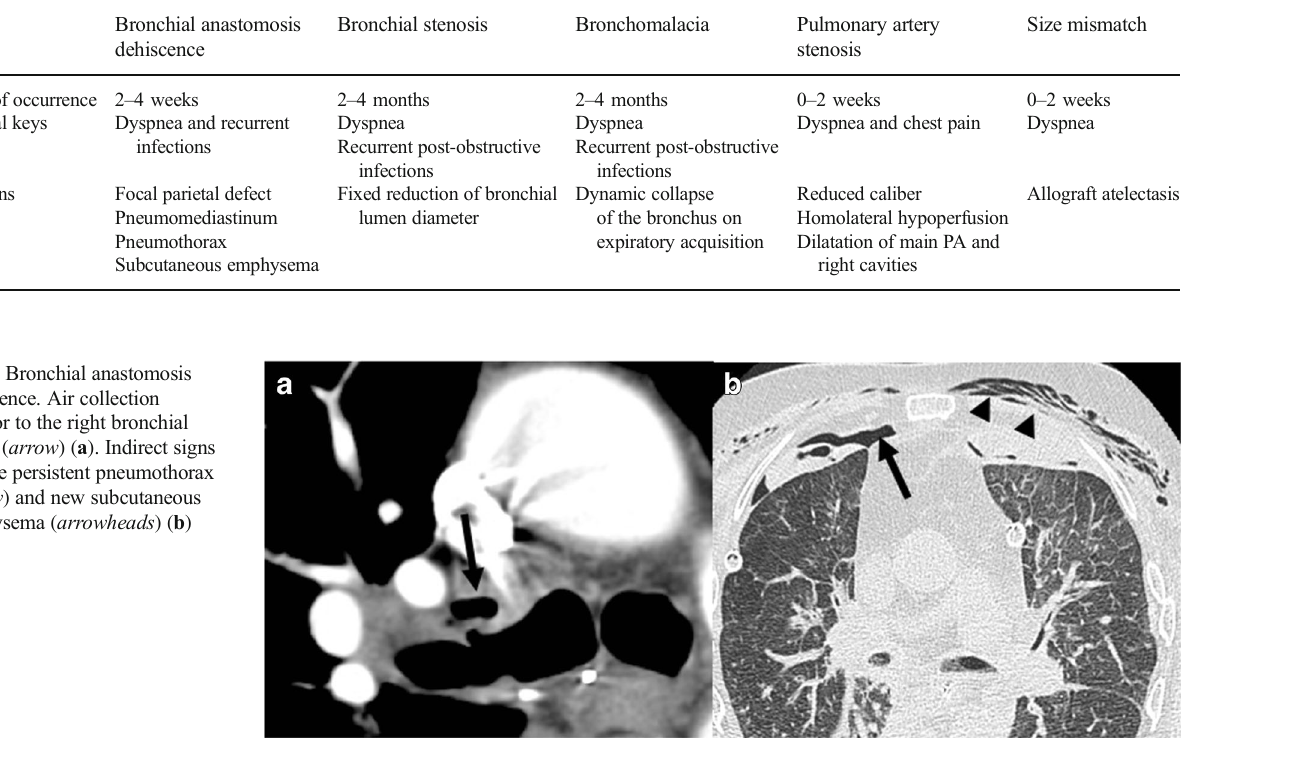
Computed tomography (CT) findings of post-surgical complications Bronchial anastomosis dehiscence